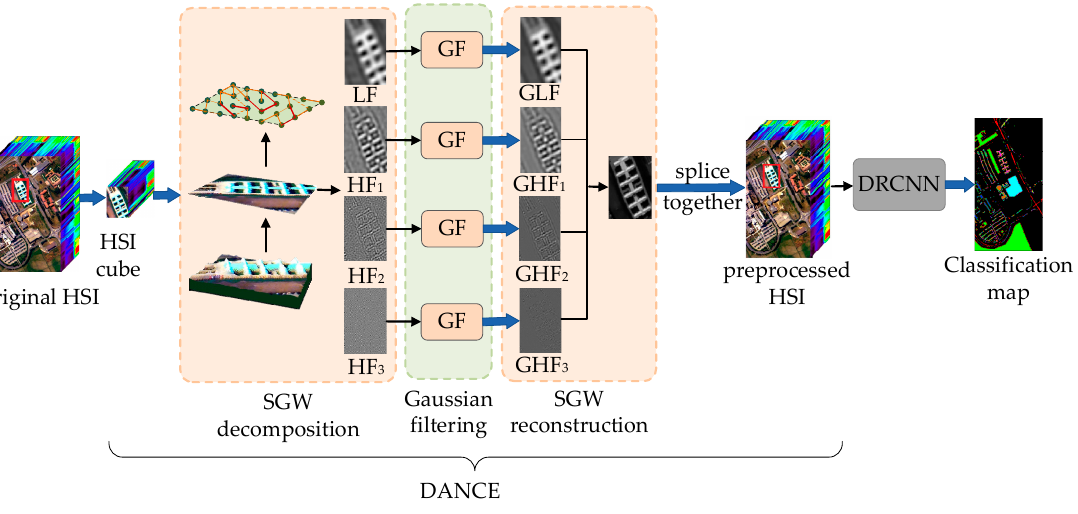
Figure 1. The overall flowchart of the proposed